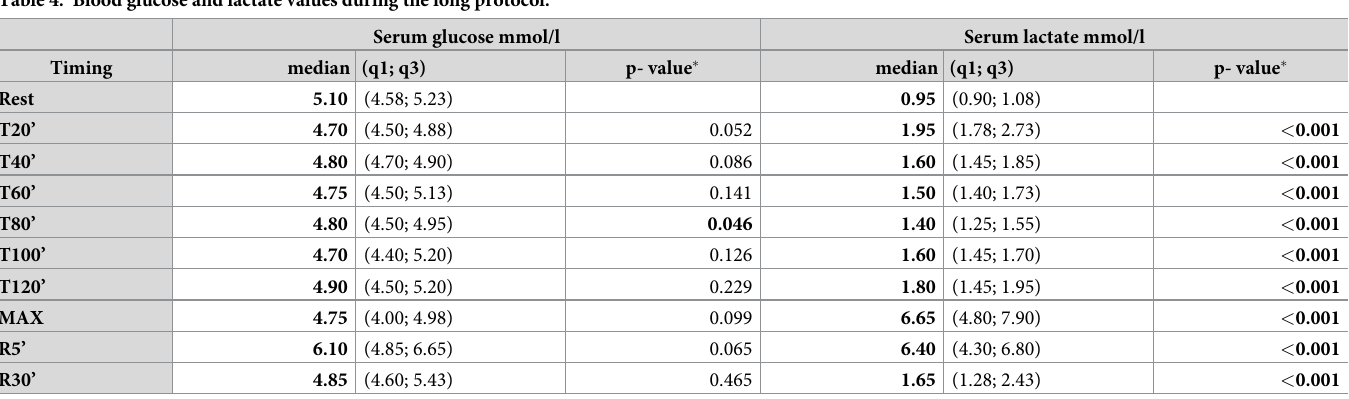
Table 4. Blood glucose and lactate values during the long